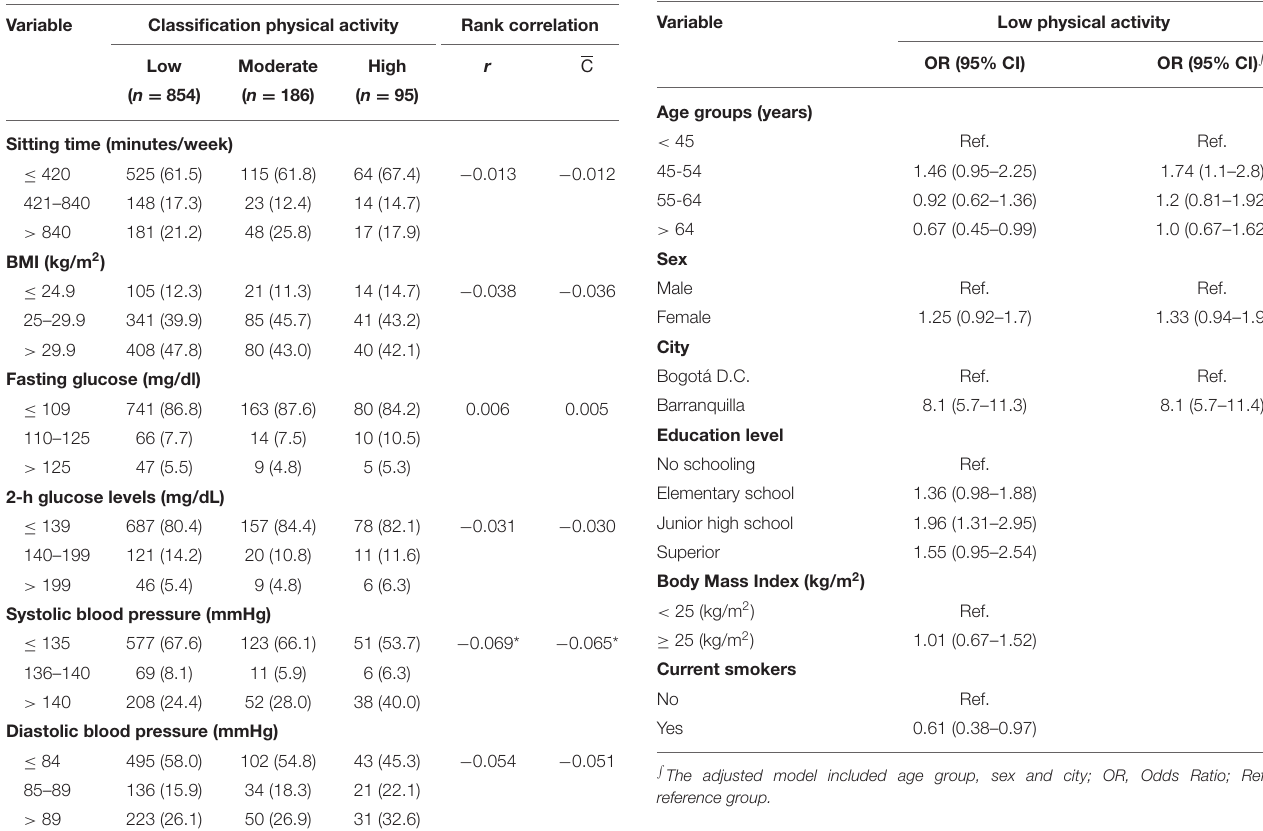
TABLE 3 | Risk factors associated with low physical activity at baseline of the